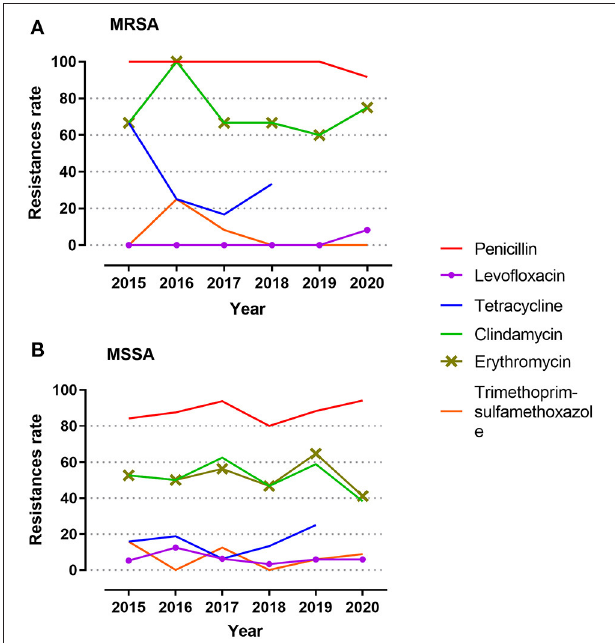
FIGURE 2 | Antibiotic resistance during the 6-year study period. (A) Resistance rates among MRSA. (B) Resistance rates among MSSA. Isolates were tested against penicillin, levofloxacin, tetracycline, clindamycin, erythromycin, and trimethoprim–sulfamethoxazole. Reasons for exclusion of antibiotics herein includes same antimicrobial drug class, 100% susceptibility, or few isolates tested during the study year. MRSA, methicillin-resistant S. aureus ; MSSA, methicillin-sensitive S. aureus .